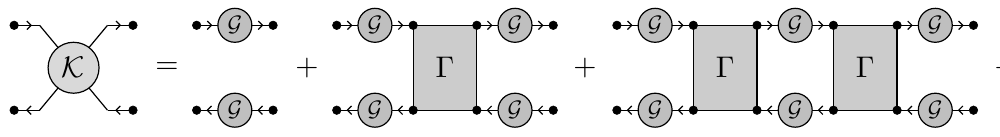
Figure 6 . The general structure of planar ladder diagrams contributing to